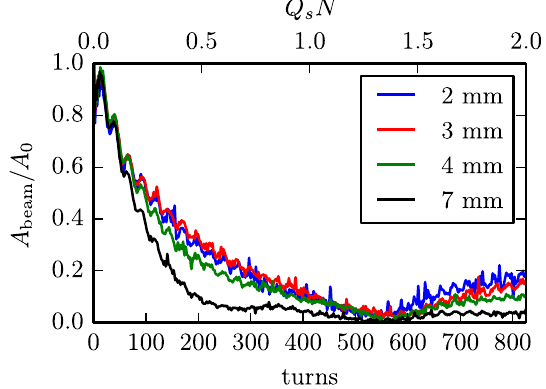
FIG. 17. Decoherence with space charge from measurements in SIS18 for different kick